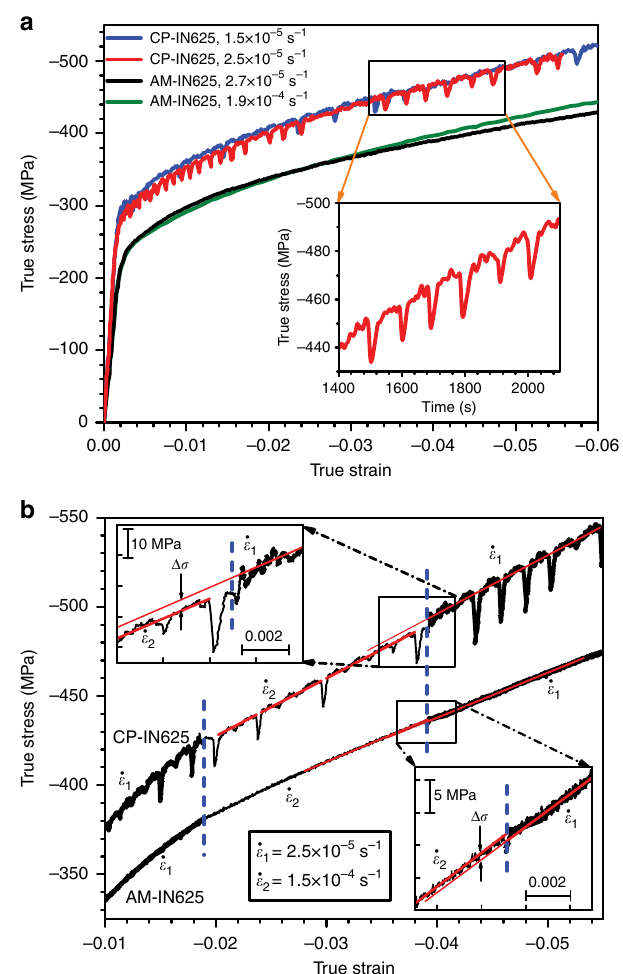
Fig. 2 High temperature mechanical behavior of conventionally processed Inconel 625 (CP-IN625) and additively manufactured Inconel 625 (AM- IN625). a Macroscopic true stress – strain curves for CP-IN625 and AM- IN625 samples deformed at different strain rates at 600 °C. The inset shows serrations in a corresponding true stress versus time plot. b True stress – strain curves for strain-rate change tests of AM-IN625 and CP- IN625 at 600°C. Insets in upper left and lower right are the enlarged views of the portion where the second strain-rate change takes place, showing how the stress change ( Δ σ ) is Δ σ is the change in fl ow stress extrapolated from the post- transition portion of the fl ow stress curve to the strain at which the strain-rate change was made, as shown in the upper left and lower right insets in Fig. 2b. As such, γ was determined to be approximately + 0.5 MPa·s for AM-IN625, and approximately − 2.2 MPa·s for CP-IN625. It is noted that the negative value of γ for the CP-IN625 is comparable to the values observed for Inconel 600 (~ − 2.0 to − 3.0 MPa·s) at 437 °C under similar stresses 9 . Additional tests performed on as-deposited and heat-treated AM- IN625 samples are presented in Supplementary Note 2.